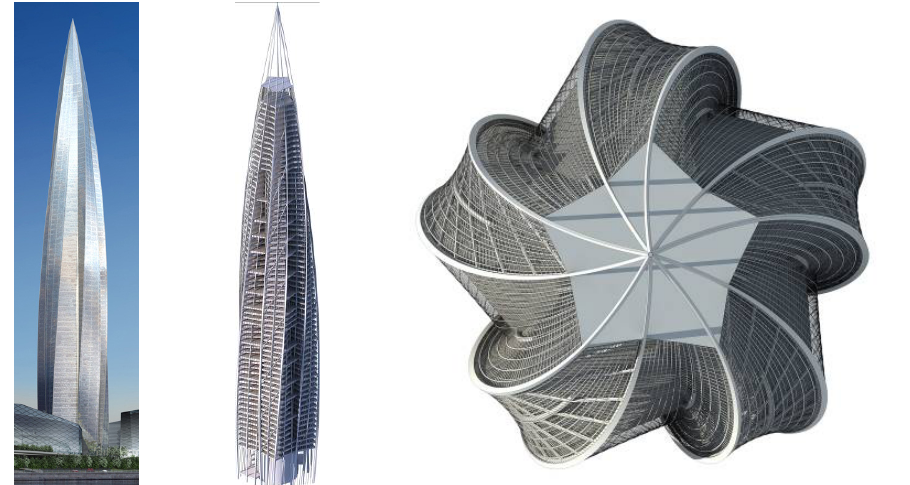
Fig. 1abc: Okhta Gazprom tower, under construction in St. Petersburg, Russia (by RMJM); superstructure sideview; topview.